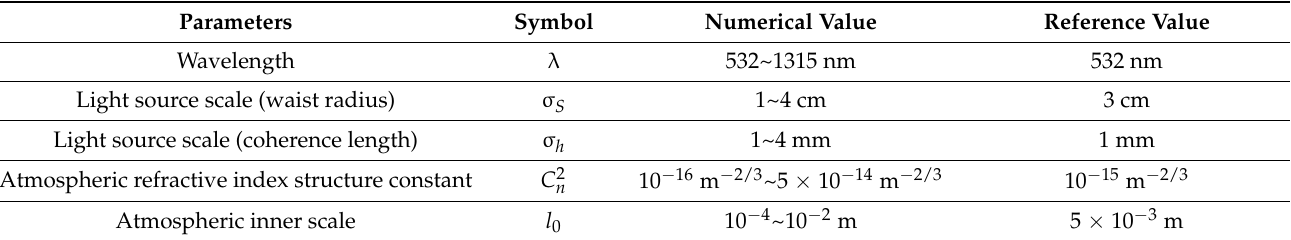
Table 1. Range of parameter values in the numerical